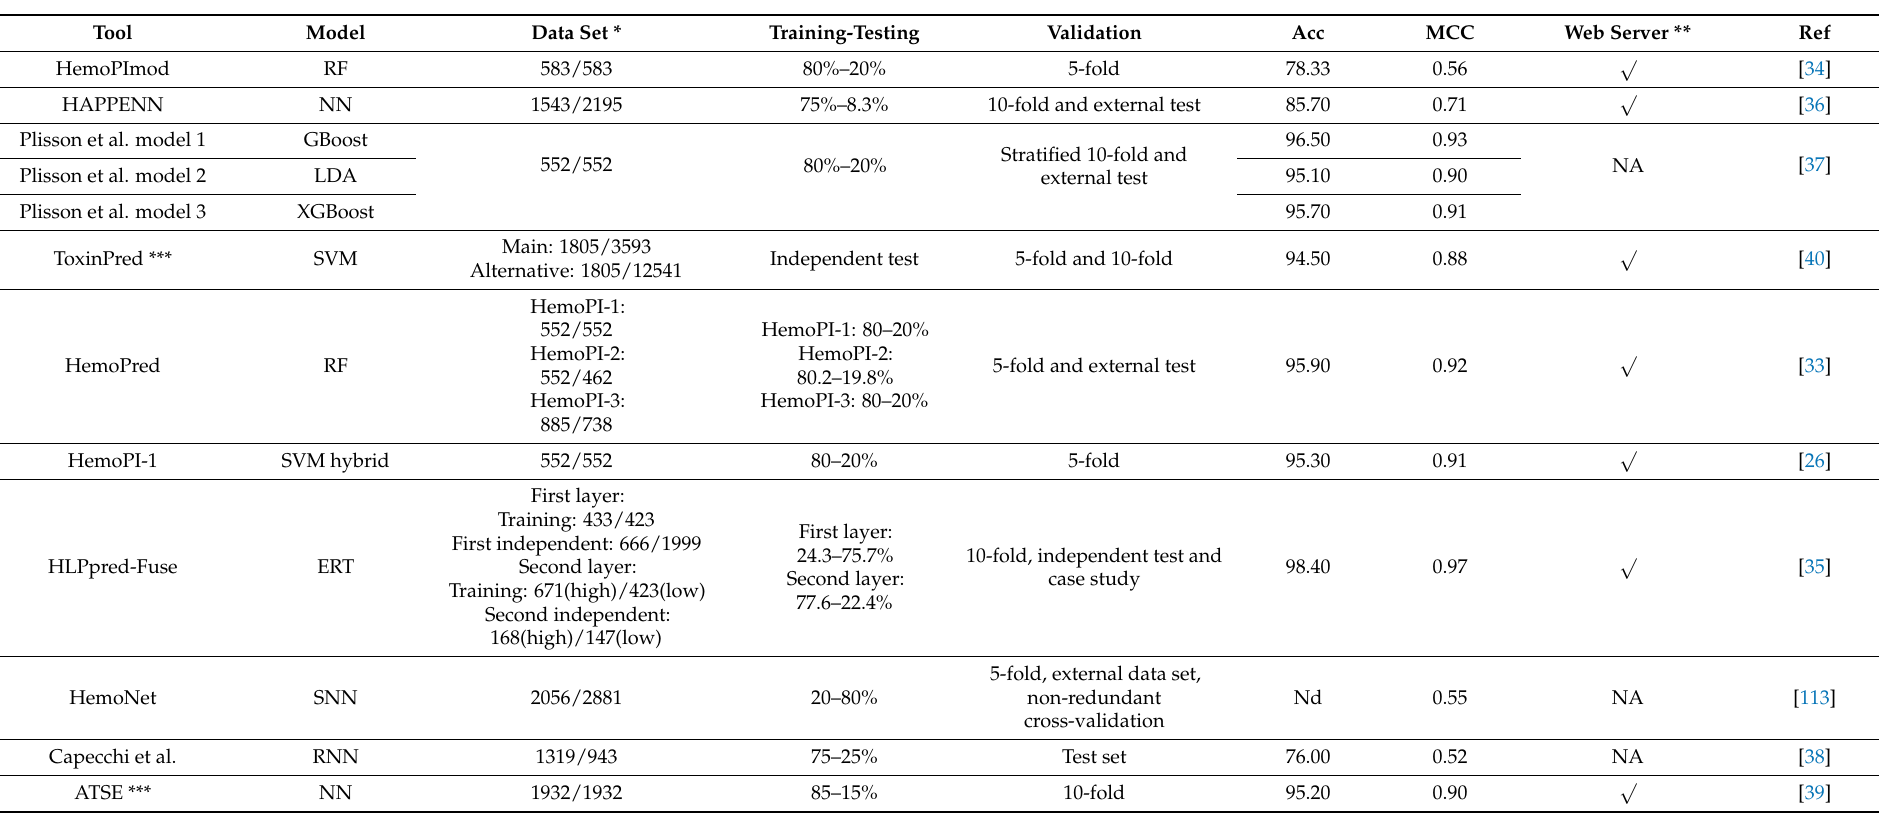
Table 3. Accuracy, Matthew’s correlation coefficient, summary of data set, and evaluation strategies of the models used by each of the ten programs used to predict the hemolytic activity of peptides. Accuracy and MCC are only reference values and are not comparable between different models unless they have used the same database. HemoPiMod is the only hemolytic action prediction server that takes into account chemical modifications of peptides. HemoNet is the only server that focuses on C/N terminal and L or D amino acid modifications to perform classification. All other tools predict hemolytic activity from natural sequences without any